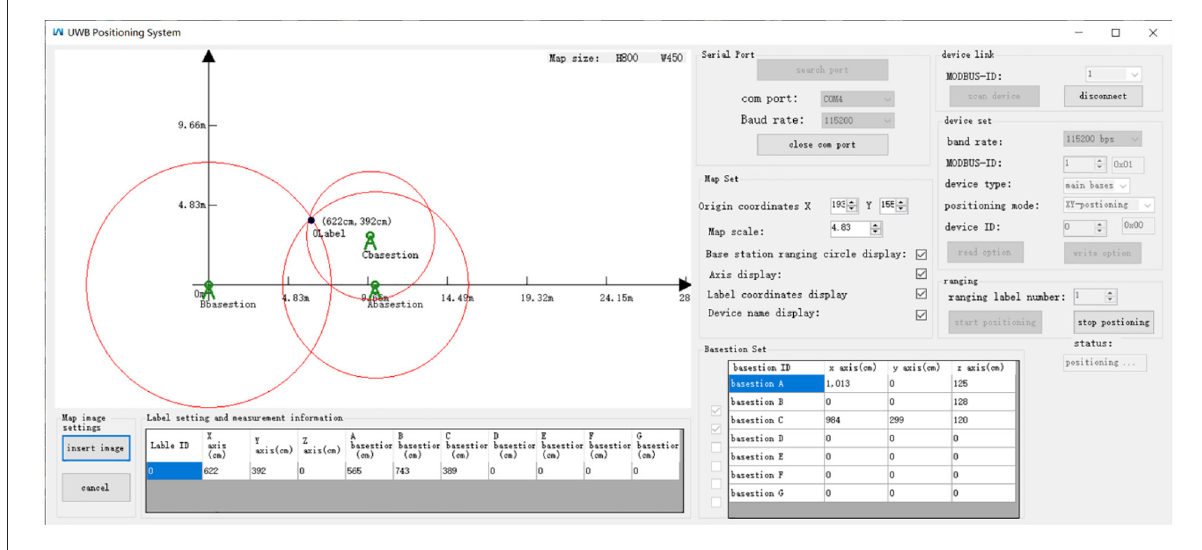
FIGURE13 A schematic representation of the upper computer interface.